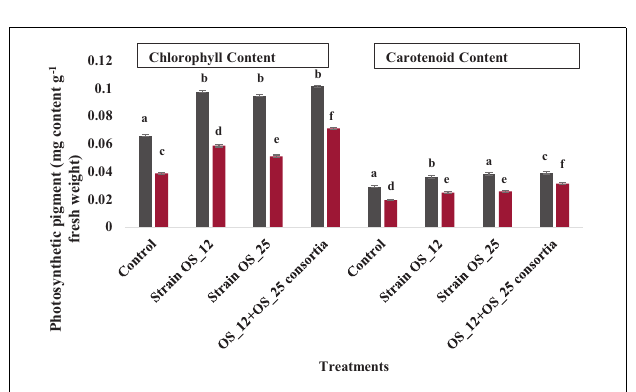
FIGURE 9 | Effect of endophytic biostimulant strains OS_12 and OS_25 plant on photosynthesis associated pigments- total chlorophyl and carotenoid content of pea plants under normal (dark gray bar) and pathogenic F. oxysporum stress (dark red bar) conditions. Columns represent mean values ± standard deviation ( n = 3 replicates per treatment). Different letters indicate statistical difference between treatments (Turkey’s posttest, P < 0.05) in enhancing chlorophyll and carotenoid content under normal and biotic stress